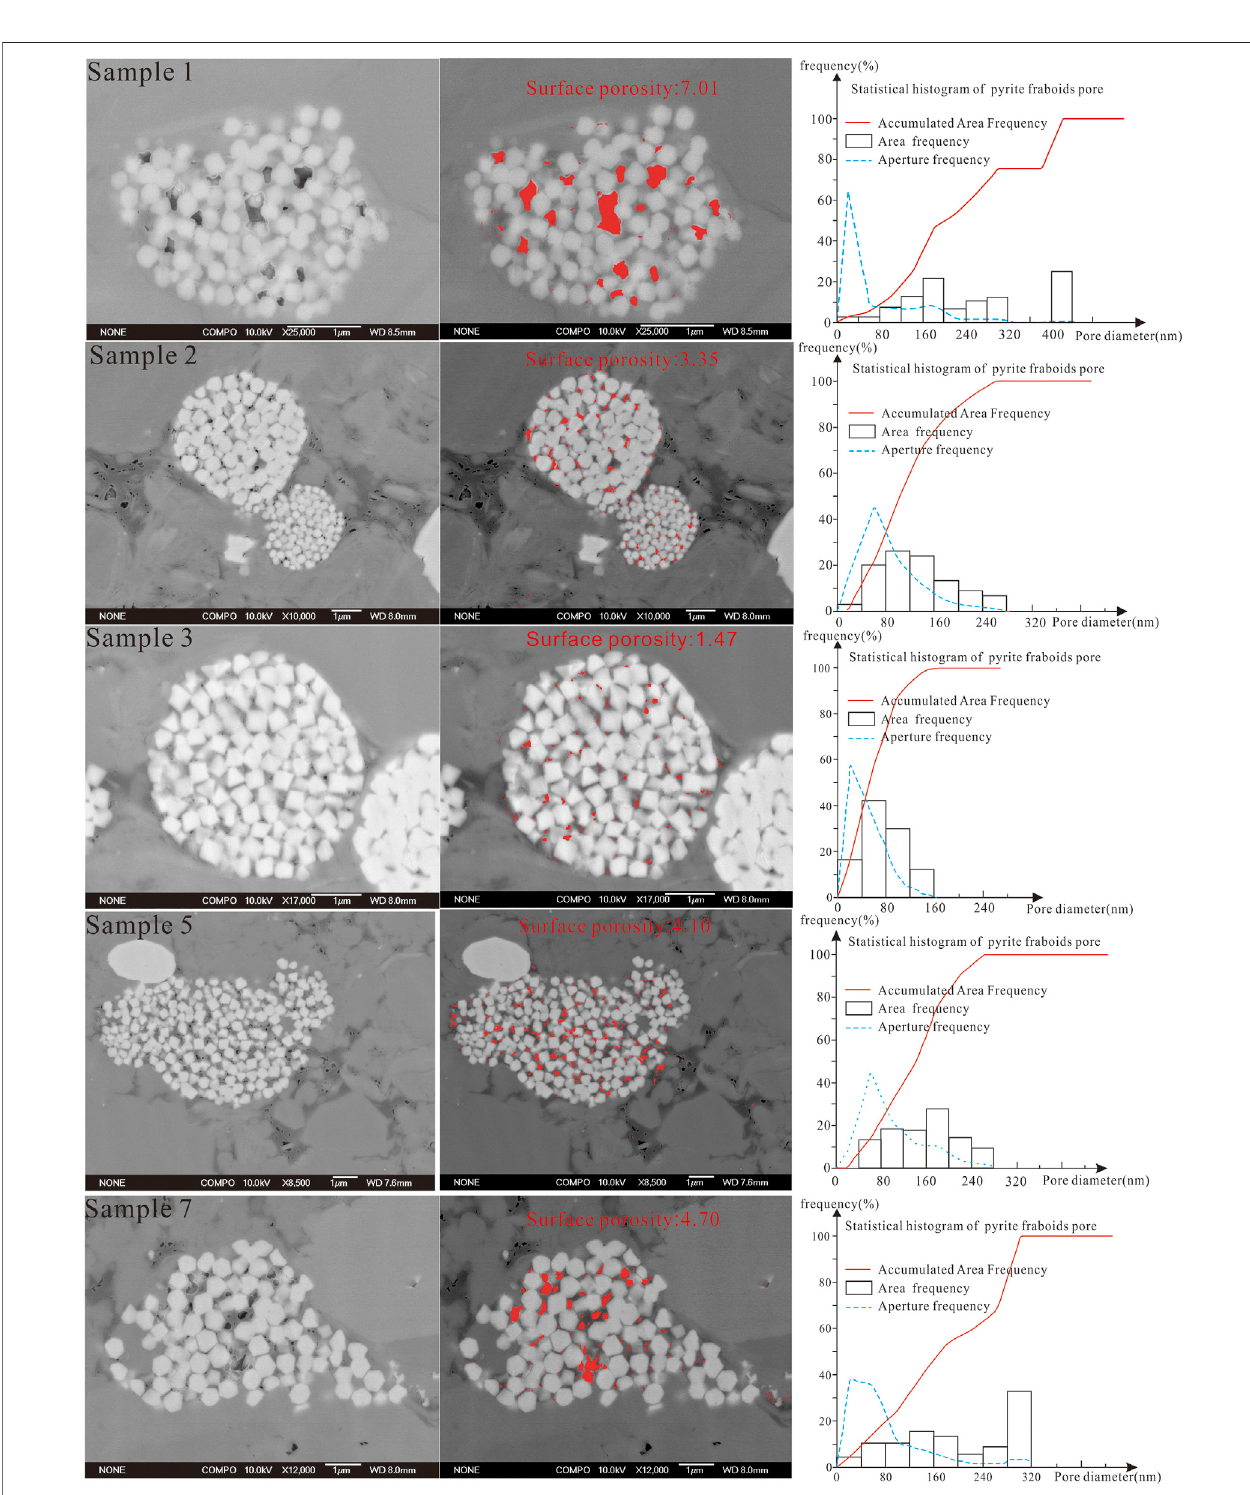
FIGURE 4 | Quantitative characterization of pores in pyrite framboids of shale samples from X2 well. 1, Black shale, X2 well, 2330.46 m; 2, black shale, X2 well, 2335.30 m; 3, black shale, X2 well, 2346.50 m; 5, black shale, X2 well, 2366.74 m; 7, black shale, X2 well, 2402.55 m.